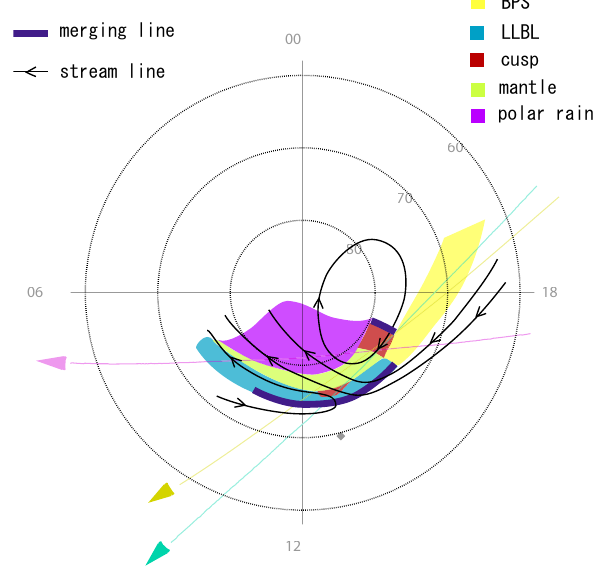
Fig. 9. Schematic diagram illustrating reconnection sites and pre- cipitation signatures. DMSP orbits are also displayed (F13 in ma- genta,F15cyan,andF16yellow).